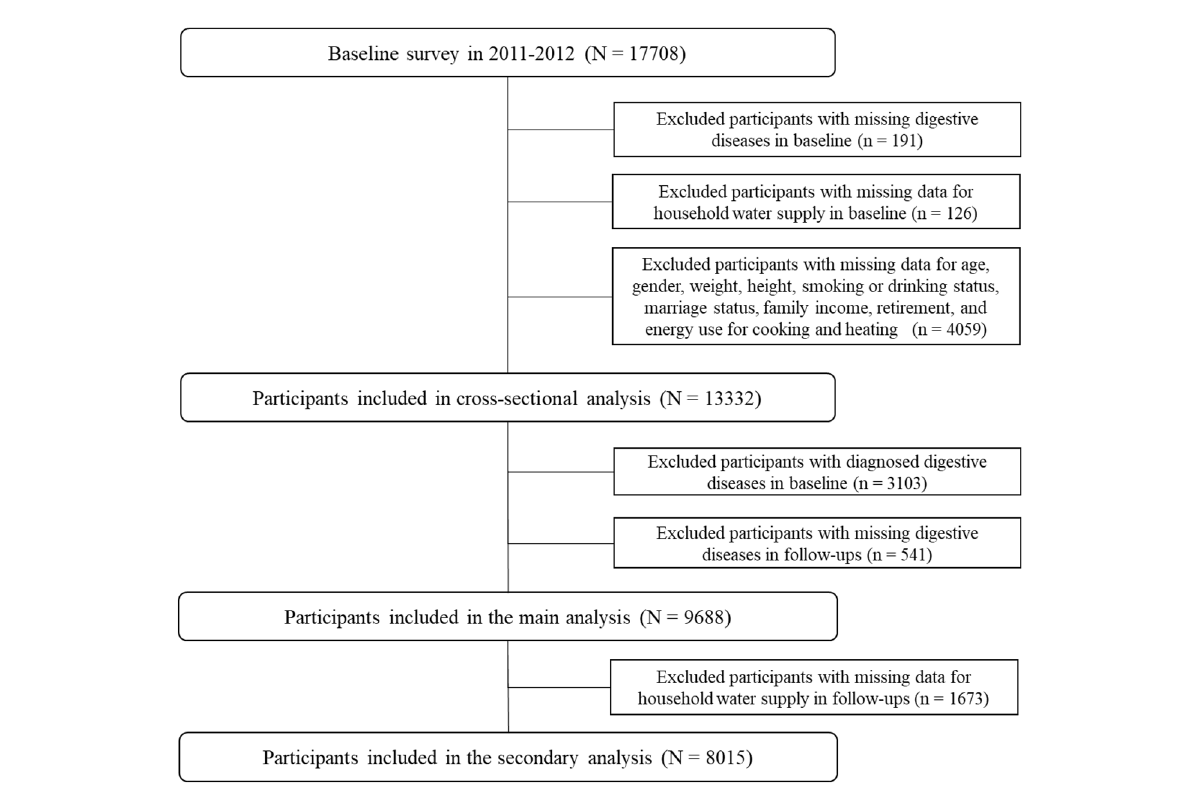
FIGURE1 Selection process for included